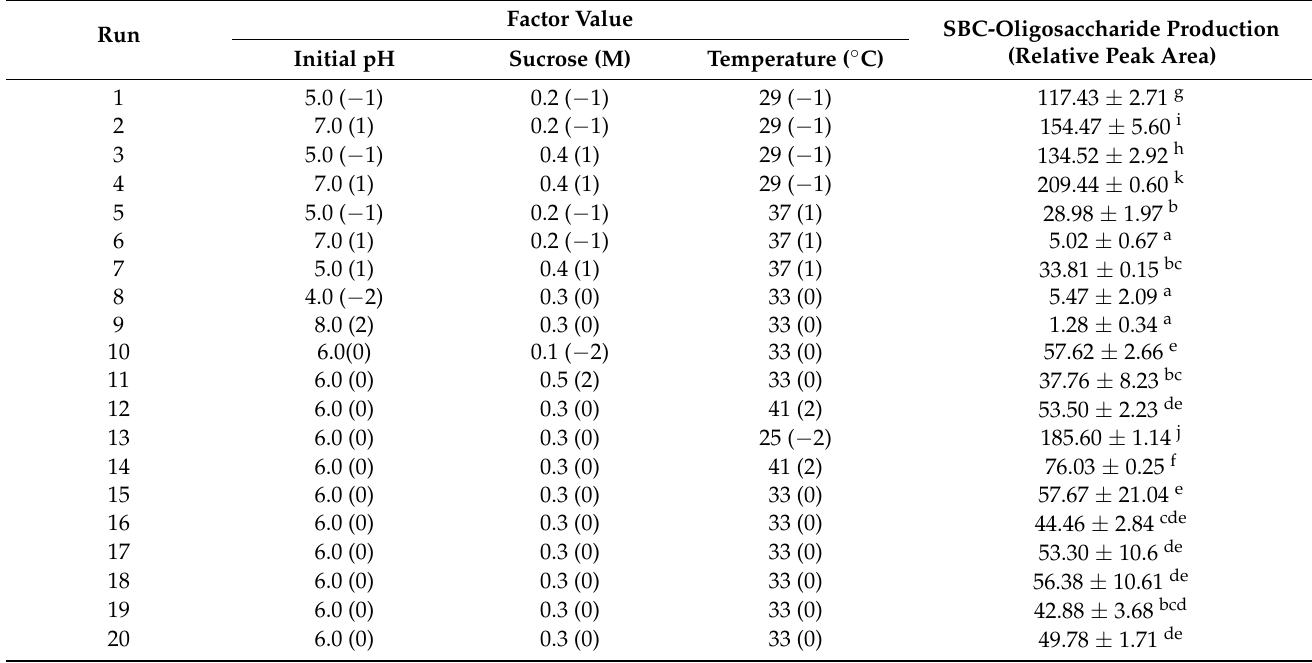
Table 2. Central composite design for three factors and the resulting SBC-oligosaccharide production.